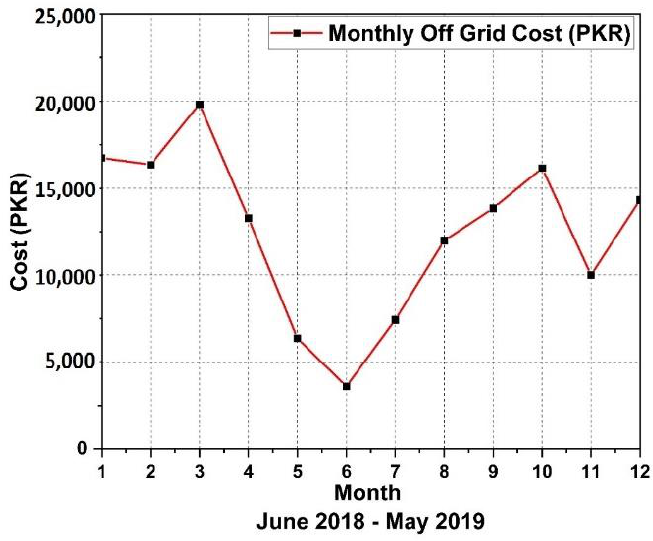
Figure 15. Monthly off − grid model costing.